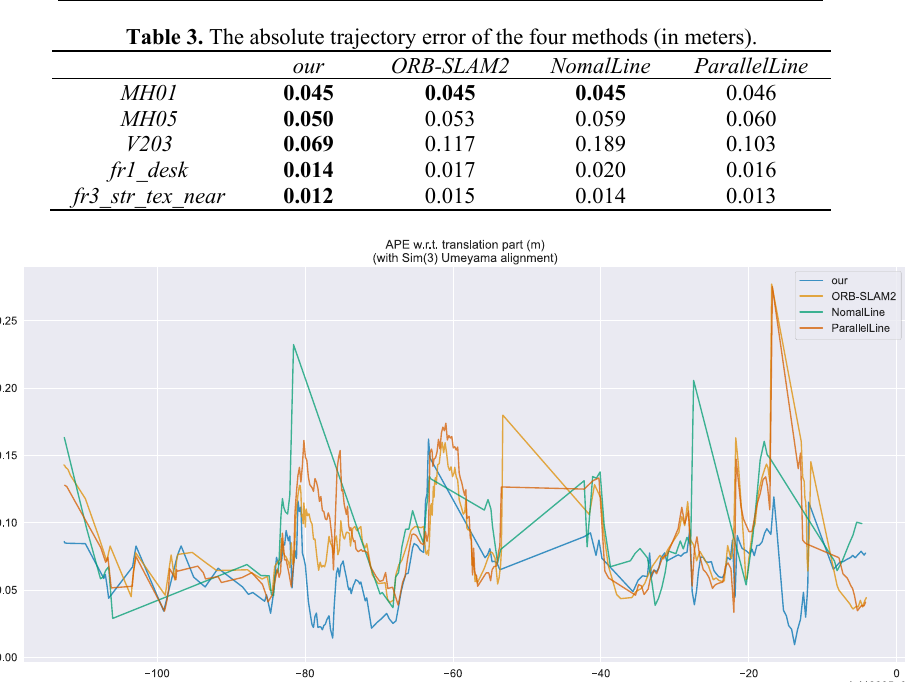
Table 2. Time-consuming of the four methods (in seconds).